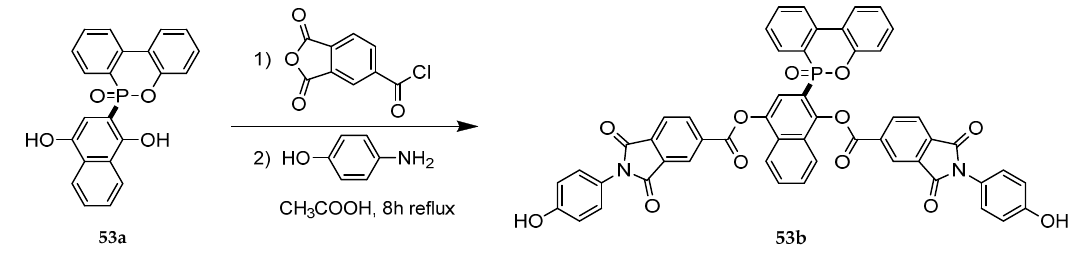
Figure 26. Phosphonate derivatives 56a and 56b . 4.4. Michaelis–Arbuzov Rearrangement In the same work [104], phosphonoterephthalic acid derivative 56c (Figure 27) was synthesized using a Michaelis–Arbuzov rearrangement from a previously published synthesis protocol [105]. Compounds 56d and 56e (Figure 27) syntheses were also based on a previous study from the same group (exhibiting m.p. of 296–298 °C and 310 °C, respectively). The syntheses involved iodoester reagents with palladium catalyst in a yield of around 80%. PU foams were prepared with compounds 56a to 56e according to two different processing methods: Preps (reactive flame retardant copolymerized during PU foam formation) and Blends (10 wt % of flame retardant additive used with already prepared PU). These foams were analyzed for thermal and flame retardant behavior using TGA and PCFC, respectively. It was found that compound 56e did decrease the heat release and inhibited melting and flowing of the PU in the Blend form. In the Prep form, the addition of this compound did not affect the heat release. The resulting PU formulation also had a two-step thermal degradation and increased char yield at 800 °C (neat PU around 9% and PU with 10 wt % flame retardant around 29%). For compound 56d , the Prep form didn’t affect either the heat release, but, in the Blend form, it induced a significant decrease of the THR. One possible explanation of this